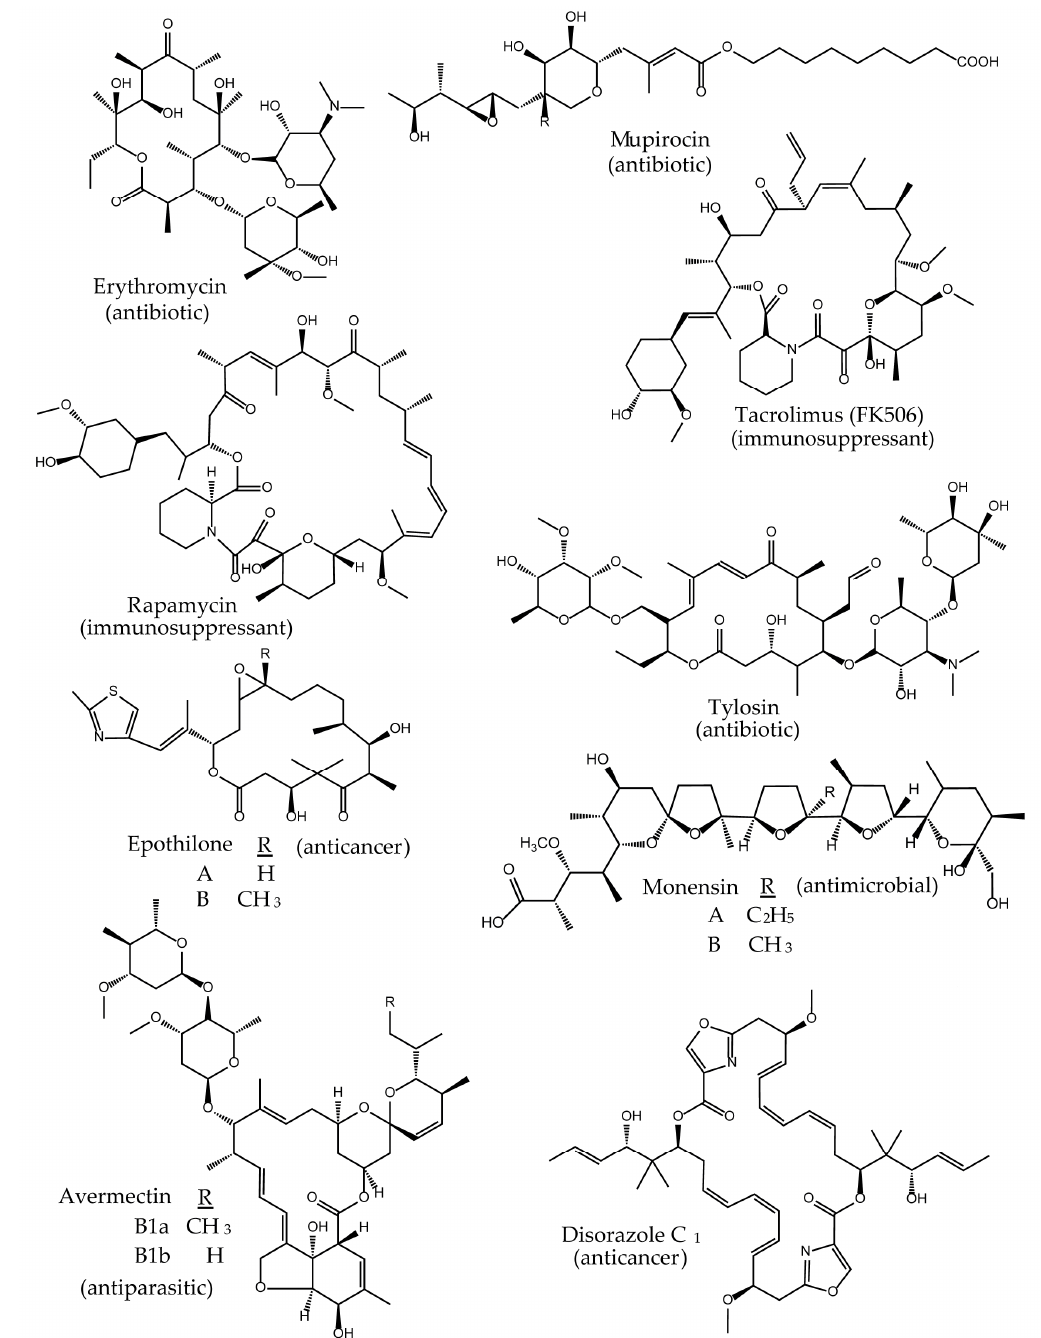
Figure 1. Structures and bioactivity of clinically relevant polyketides.